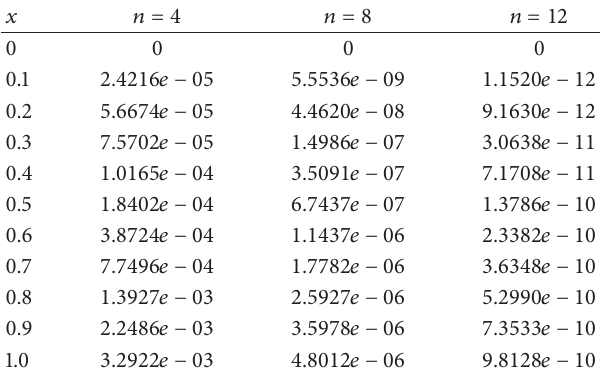
Table 4: Absolute errors for Example 4 at different 𝑛